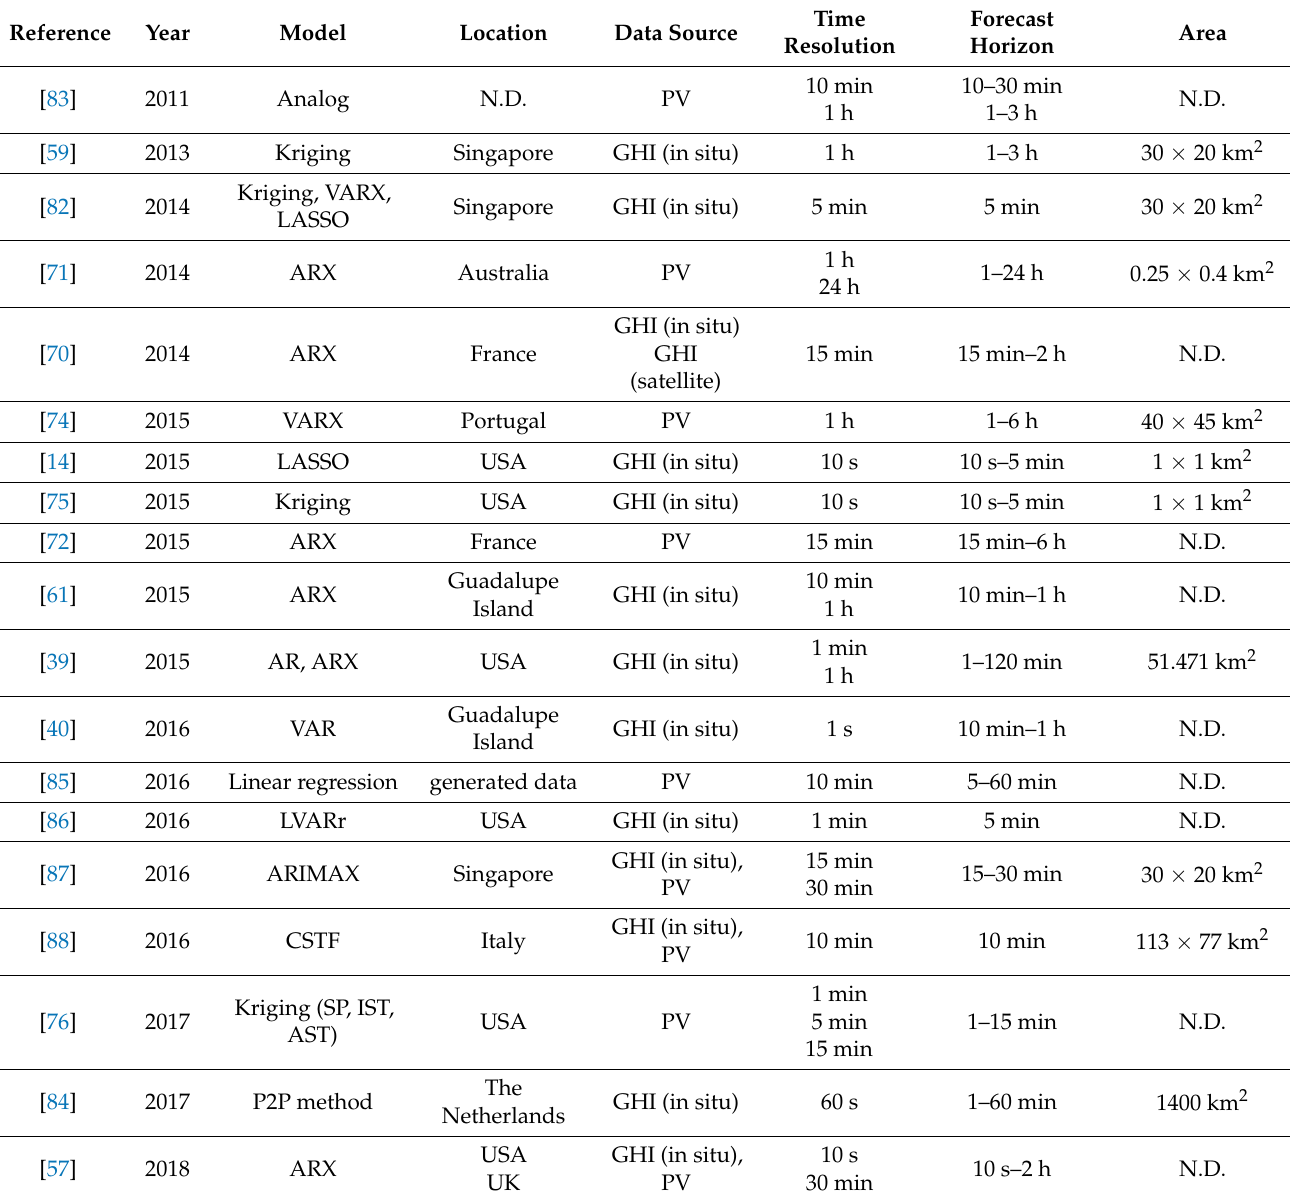
Table 2. Summary of available literature (2011–2021) for the application of statistical methods regarding spatio-temporal solar forecasting